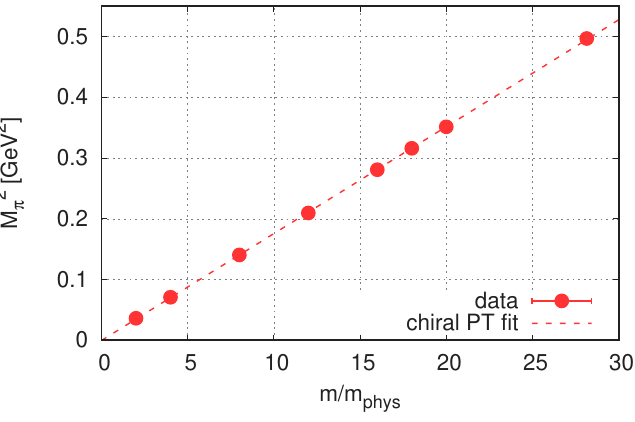
Figure 5 . The squared pion mass as a function of the light quark mass. The dashed line indicates the linear dependence predicted by chiral perturbation